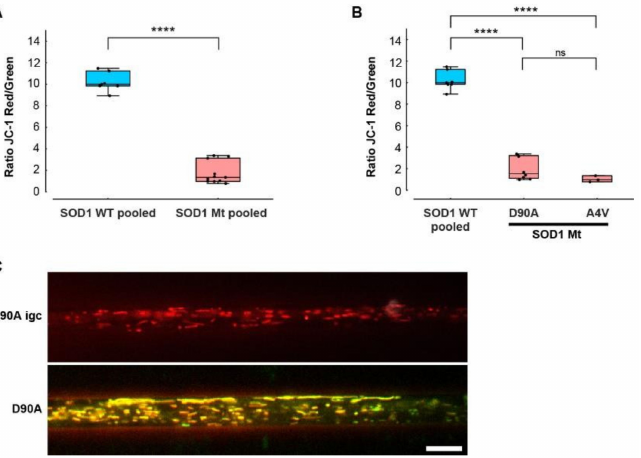
Figure 7. Reduced mitochondrial inner membrane potential in mutant SOD1 spinal MNs. ( A , B ) Box plots of membrane potential (fluorescence intensity ratio of JC1 red/green channel), mean values per experiment (black dots) for each respective line with 25–75% interquartile range (box), median (horizontal line), and non-outlier range (1.5-fold interquartile range added above and below to box, whiskers). SOD WT pooled: data from all SOD WT lines including D90A igc were pooled ( n = 7) as listed in Table 1. SOD Mt pooled: data from D90A ( n = 8) and A4V ( n = 3) (Table 1) were pooled ( n = 11). Asterisks: highly significant increase in pairwise comparison of control cells (in blue) with each mutant line (in red), respectively, unpaired two-tailed Student’s t -test ( A ) or one-way ANOVA with Bonferroni post test ( B ). **** p < 0.0001, n.s. not significant. ( A ) Membrane